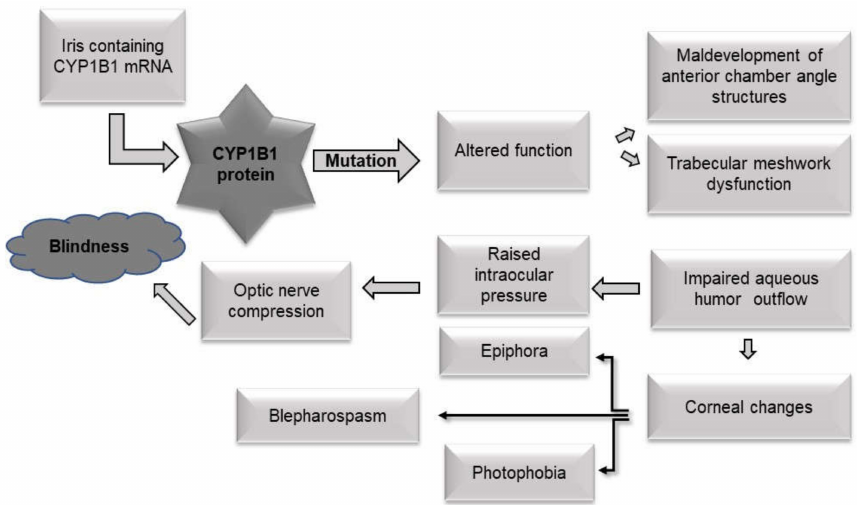
Figure 2. The pathophysiology of primary congenital glaucoma (PCG). The most accepted theory for the pathophysiology of PCG resulting from the failure of the CYP1B1 downstream pathways in the development of functional ocular structures. Early blindness results from damage to the optic nerve due to elevated intraocular pressure (IOP)